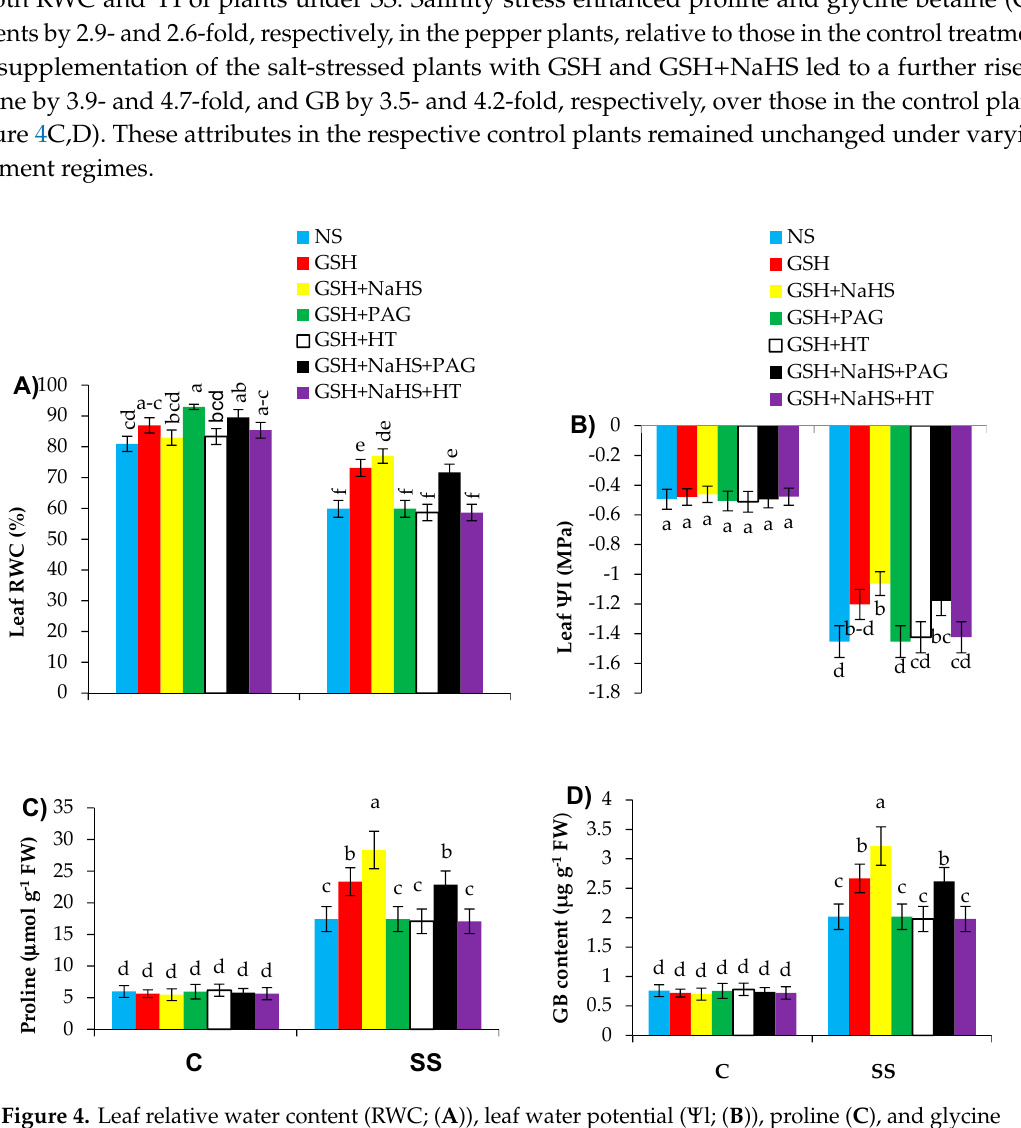
Figure 3. Chlorophyll a ( A ) and chlorophyll b ( B ) on a fresh weight (FW) basis and chlorophyll fluorescence parameters ( F v/ F m ( C )) in pepper plants grown under control ( C ) and salinity stress (SS 100 mmol L − 1 NaCl), sprayed with glutathione (1.0 mmol L − 1 GSH) or sodium hydrosulfide (0.2 mmol (0.1 mmol L − 1 HT), or inhibitor of l -DES, dl -propargylglycine (0.3 mmol L − 1 PAG). (Mean ± SE). Mean L − 1 NaHS) alone or together, combined with a 0.1 mmol L − 1 scavenger of H 2 S, hypotaurine (0.1 mmol L − 1 HT), or inhibitor of L -DES, DL -propargylglycine (0.3 mmol L − 1 PAG). (Mean ± SE). Mean values values carrying di ff erent letters within each parameter di ff er significantly ( p ≤ 0.001) based on Duncan’s